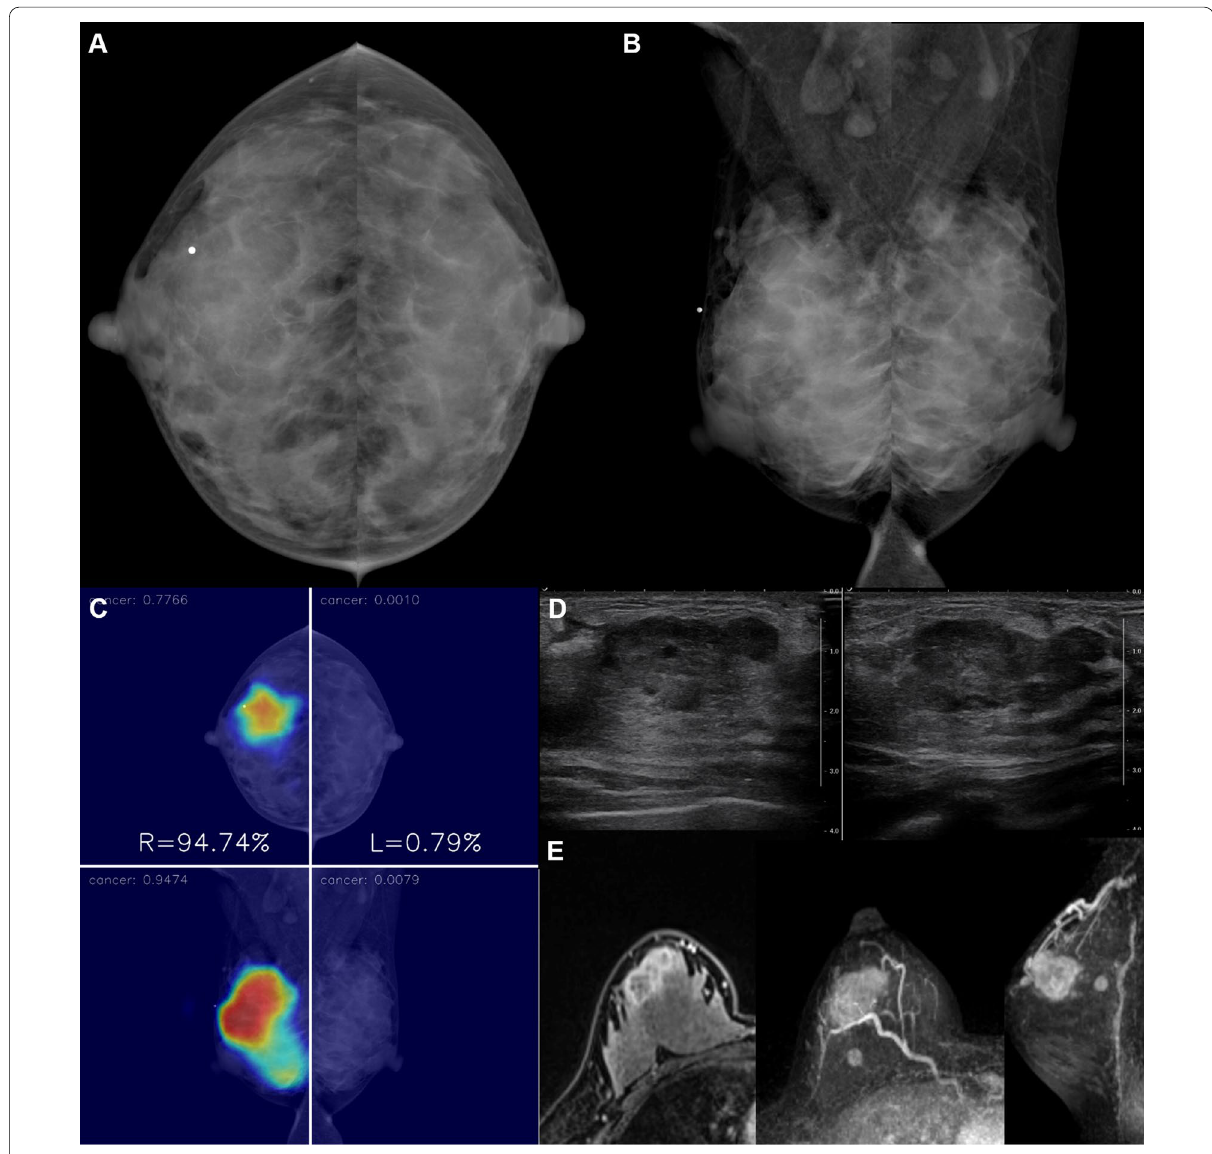
Fig. 4 A 31-year-old woman with invasive ductal carcinoma in the right breast. a , b A BB marker was attached at the upper outer quadrant of the right breast, but no abnormal finding was detected in both breasts by a radiologist. c – e AI highlighted a focal area in the upper outer quadrant of the right breast, which correlated with the location of the cancer in US and MRI. The malignancy score of the cancer was 94.7. Histopathologic examination of core needle biopsy showed a high histologic grade invasive ductal carcinoma that was estrogen receptor-negative, progesterone receptor-negative, and human epidermal growth factor receptor-2-negative. Right mastectomy was performed after neoadjuvant chemotherapy, and a residual invasive ductal carcinoma was